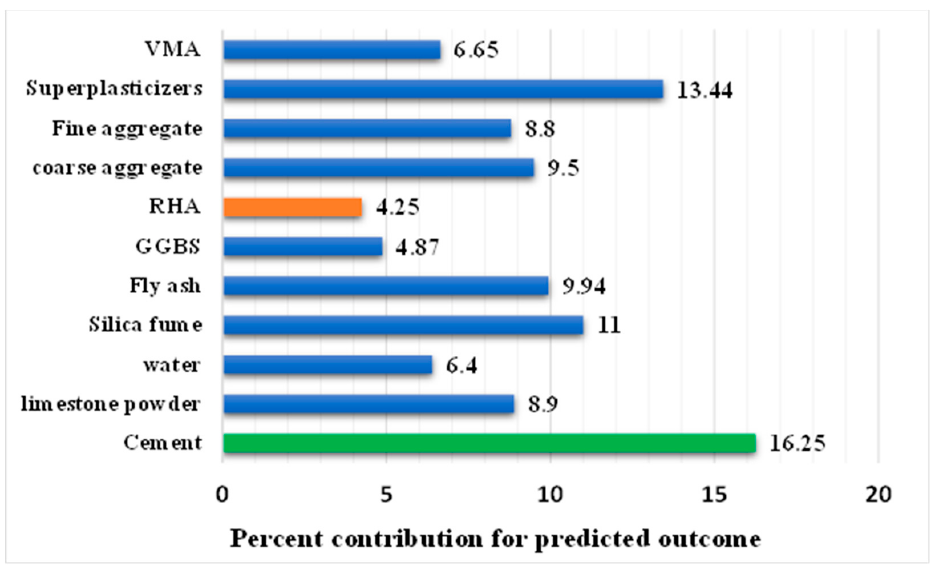
Figure 22. Influence of the input parameters towards the predicted output.